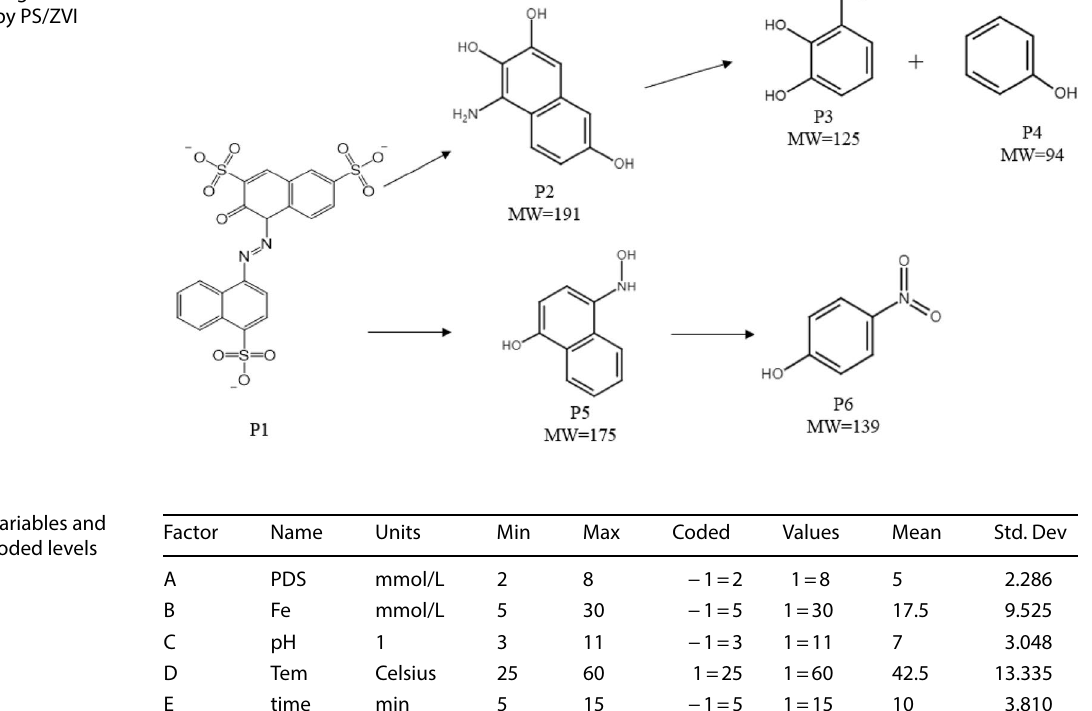
Fig. 12 A logical degradation pathway of AMR by PS/ZVI system